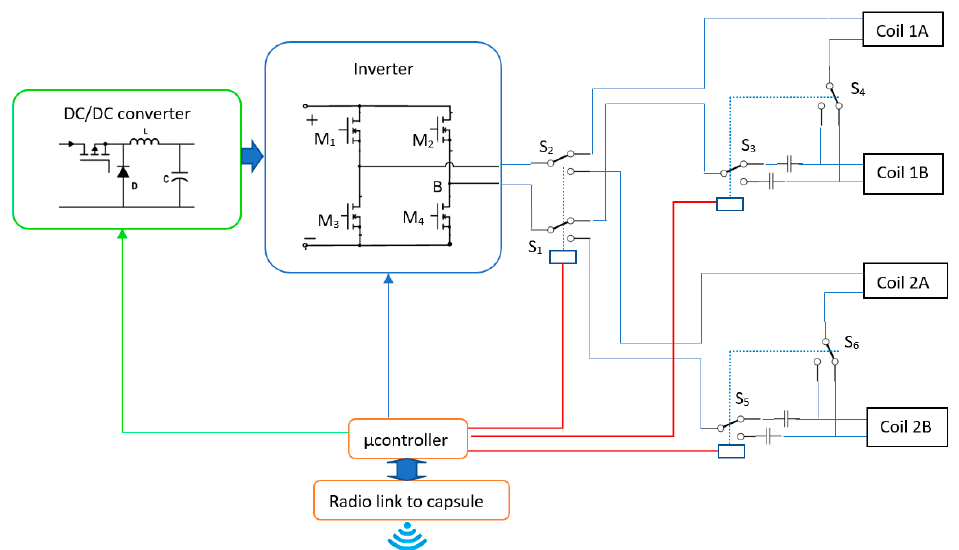
Figure 9. Proposed electronic configuration of the transmitter side.